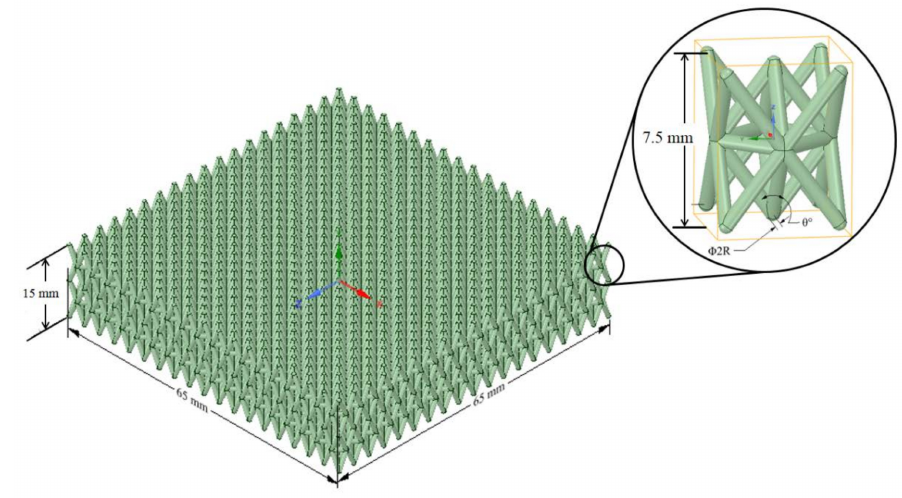
Figure 3. Geometry of cellular twisted-octet lattice